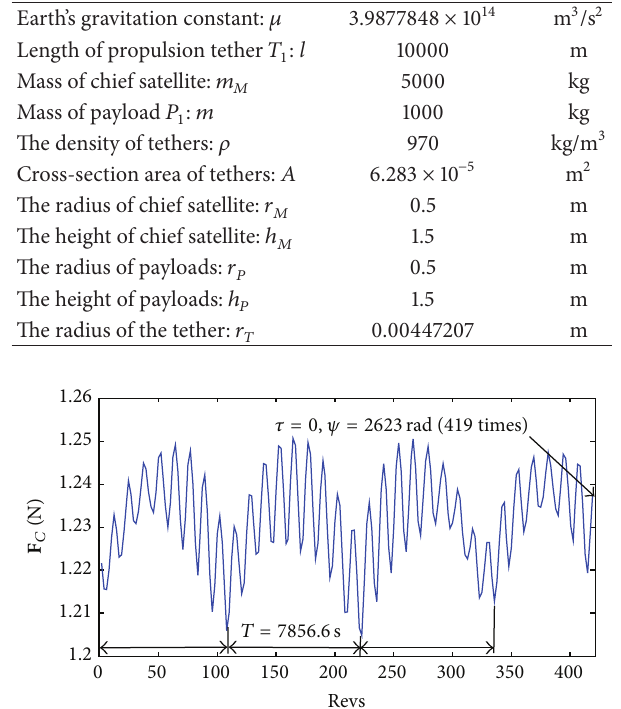
Figure 7: The relationship between F 𝐶 and revs of propulsion tether with Δ𝑙 = 0.1 m and 𝜏 = 0